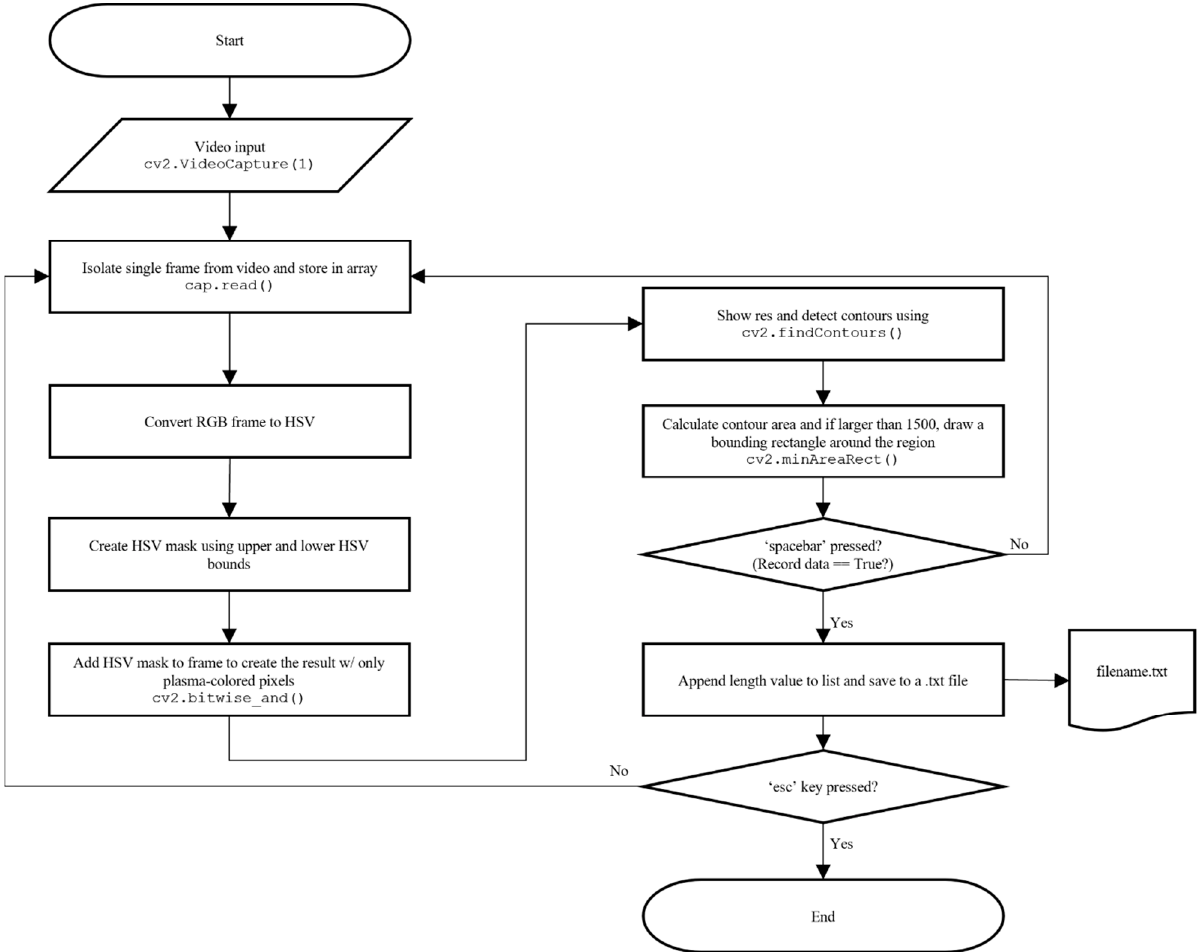
Figure 3. Program flow chart. Here, we show the main program and data collection routine. Once the .py file was run from the command line, a whole loop isolates frames, identifies plasma, and measures it.